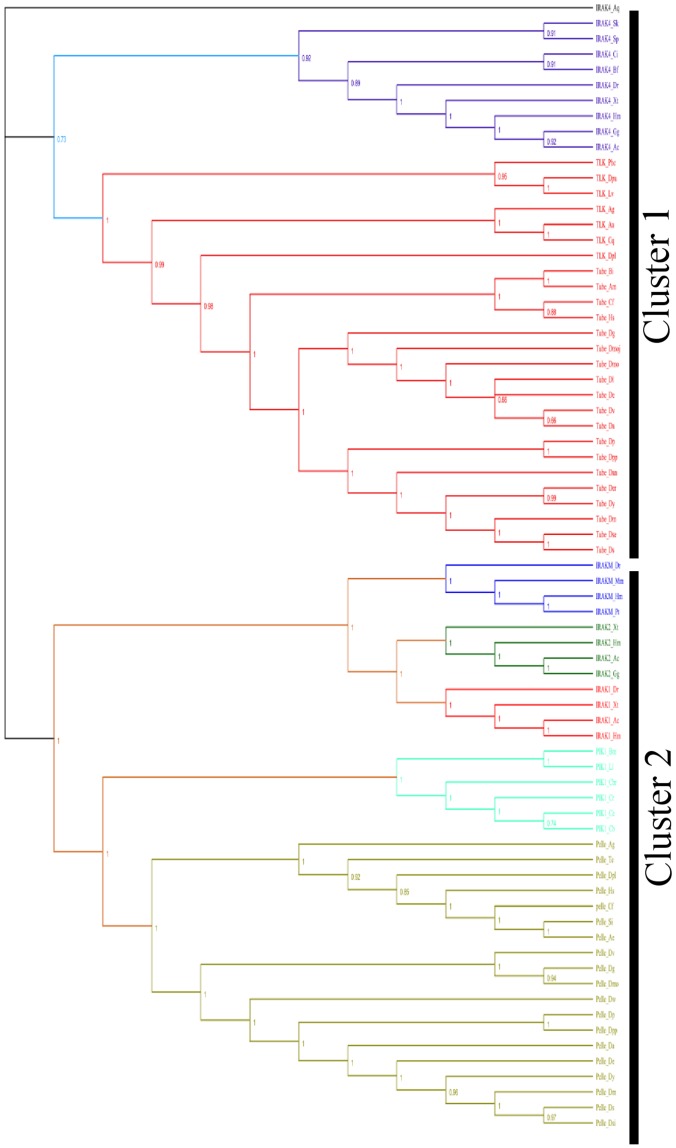
Phylogenetic analysis of IRAK genes compared with D. melanogaster homologs determined using the Bayesian inference.A total of 73 coding sequences were included in this analysis (22 representative vertebrate IRAK subfamily sequences based on taxonomy; 19 Pelle, 26 Tube/TLK, and 6 PIK-1 sequences). A. queenslandica was considered as an outgroup. The numerical values represent posterior probability. Each IRAK subfamily clade is represented by a unique color: Tube/TLK (hot pink), PIK-1 (cyan), and Pelle (khaki). Other IRAK colors are described in Figure 1. Taxonomic convention: IRAK protein name followed by an abbreviated form of the species name.